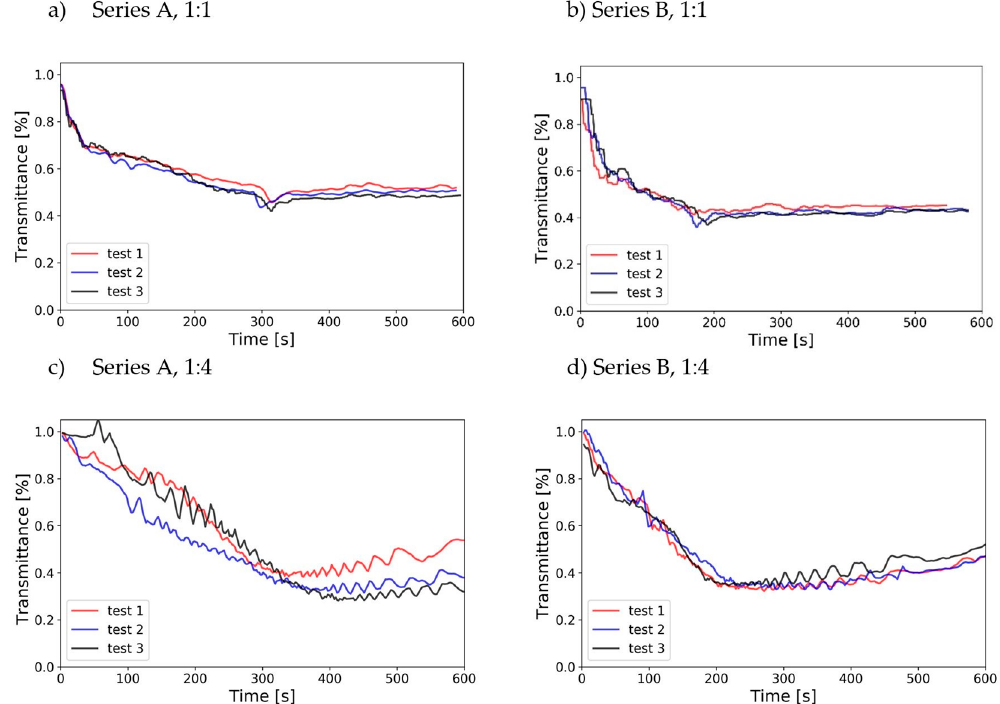
Figure 14. Measurements of transmittance of the hot gas layer in the experiments.